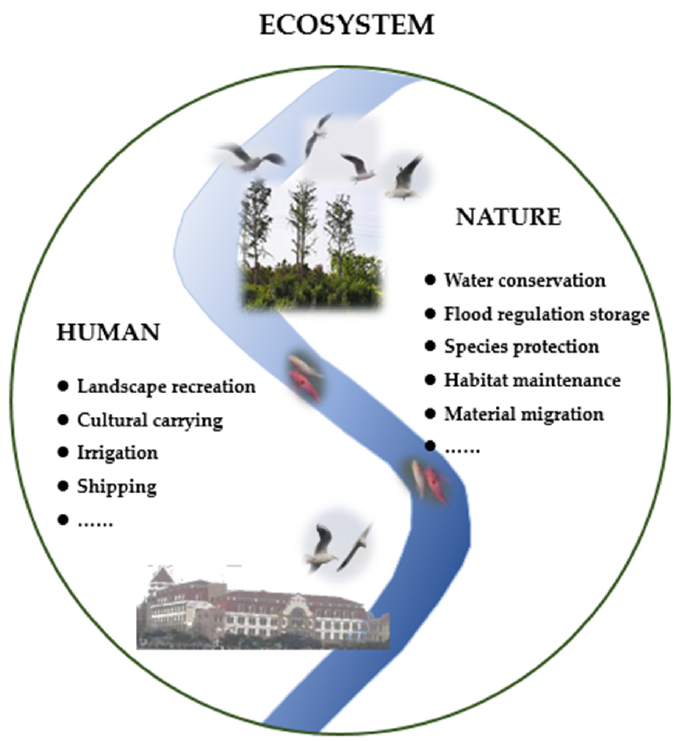
Figure 4. Ecosystem function diagram. Harmonious coexistence between humans and nature can jointly create a good ecosystem. Humans and nature have different functions for the river ecological corridor, including natural ecological function and social service function.